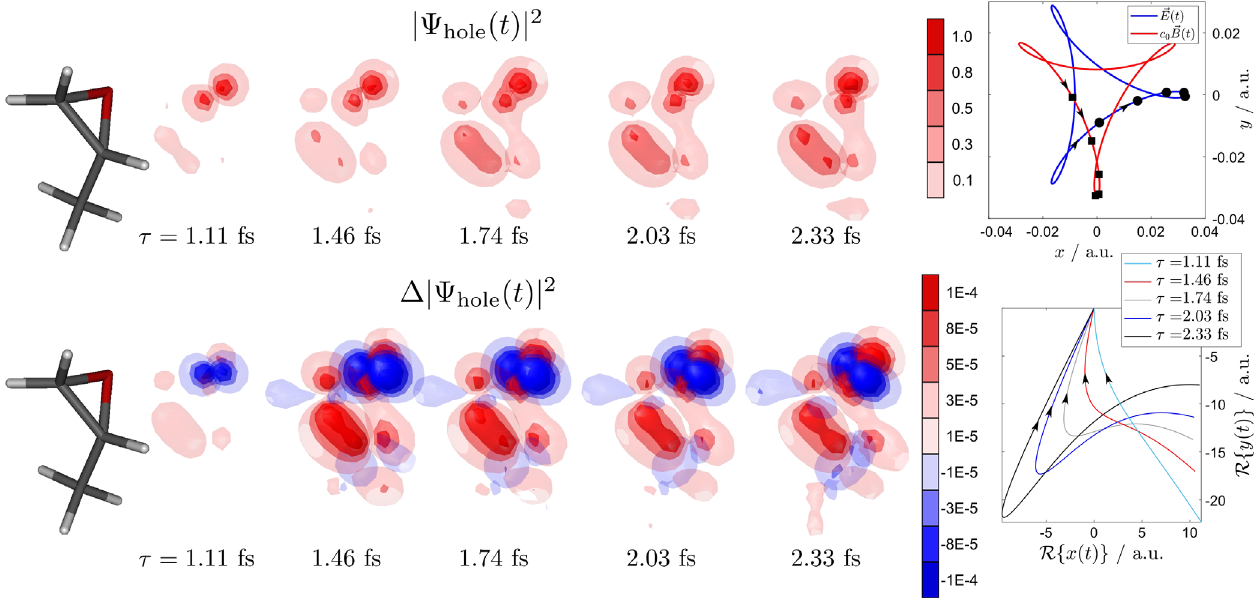
FIG. 6. Electron-hole dynamics underlying the chiral response. These simulations were done for laser parameters matching the experimental results in Fig. 1 (1800 and 900 nm, I ω ¼ 3 . 0 × 10 13 W = cm 2 , I 2 ω ¼ 1 . 1 × 10 13 W = cm 2 ) and ϕ ¼ − π = 8 , as estimated by comparison with the experimental results. Top row: Absolute magnitude of the hole density at the time of recombination for 5 harmonic orders ( H 17 , 24, 32, 40, and 48). The corresponding transit times of the continuum electron τ are indicated. Bottom row: Difference between the hole densities calculated with and without the contribution of the magnetic-dipole interaction. The contour levels are coded in the colors of the isocontour surfaces (color bar on the right). Top right: Spatial profiles of the electric (blue) and the magnetic (red) fields. The ionization times of the five trajectories are indicated as black circles (electric field) or black squares (magnetic field), respectively. Bottom right: Real part of the spatial quantum